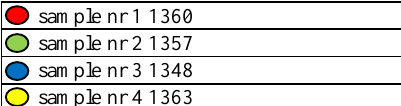
Figure 10. Mutual relation between the uncovered relics of the two defensive systems unearthed at the courtyard of the Tin-Roofed Palace. Devised by M. Sekuła